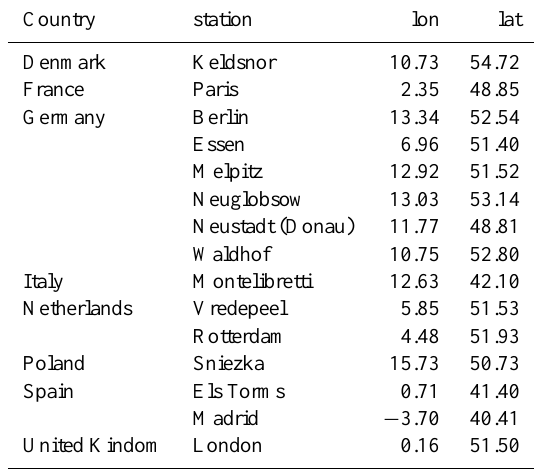
Table 1. Location of stations for detailed analysis (see also Fig.